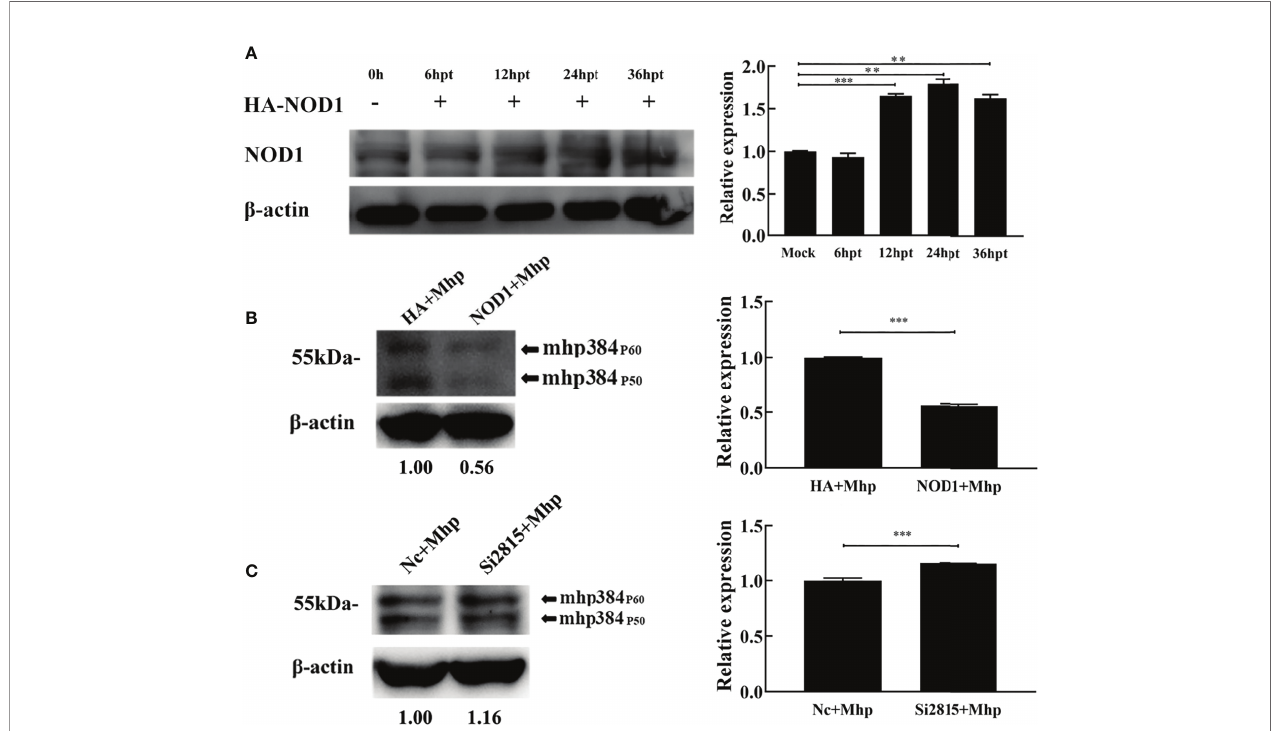
FIGURE 4 | NOD1 inhibits M. hyopneumoniae replication during infection. (A) Alveolar macrophages were transfected with pCMV-HA-NOD1 plasmid or empty pCMV-HA vector. At 0, 6, 12, 24, or 36 hpt, the cells were lysed and subjected to western blotting analysis. Relative expression levels of NOD1 are presented as folds in the right panel. (B) Cells were transfected with pCMV-HA-NOD1 or pCMV-HA for 24 h, and then infected with M. hyopneumoniae (100 m L, 10 8 CCU). (C) Cells were transfected with Nc siRNA or si2815 for 24 h, and then infected with M. hyopneumoniae (100 m L, 10 8 CCU). Cells were collected at 24 hpi, and subjected to western blotting to determine the expression of M. hyopneumoniae mhp384. ** P < 0.01, and *** P < 0.001 indicate statistically signi fi cant differences among different